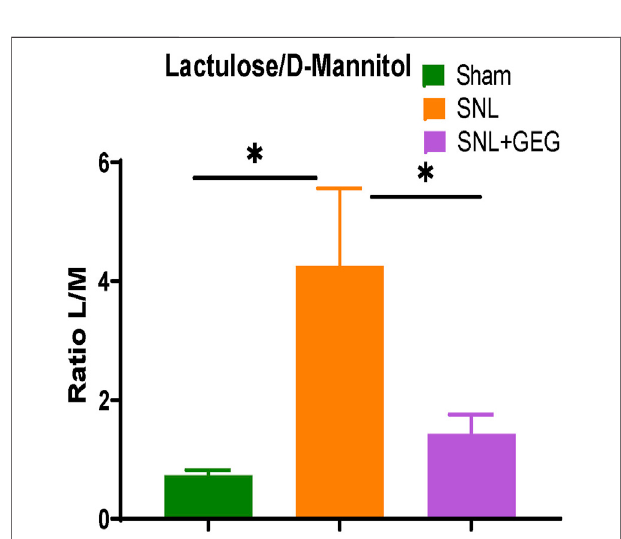
FIGURE 5 | Effect of GEG supplementation on intestinal permeability in SNL rats. The ratio of lactulose to D-mannitol (L/M) increased in the NP state. Data is expressed as mean ± SEM. n = 4 per group. Data was analyzed by one-way ANOVA followed by a post hoc Tukey ’ s test. * p < 0.05.